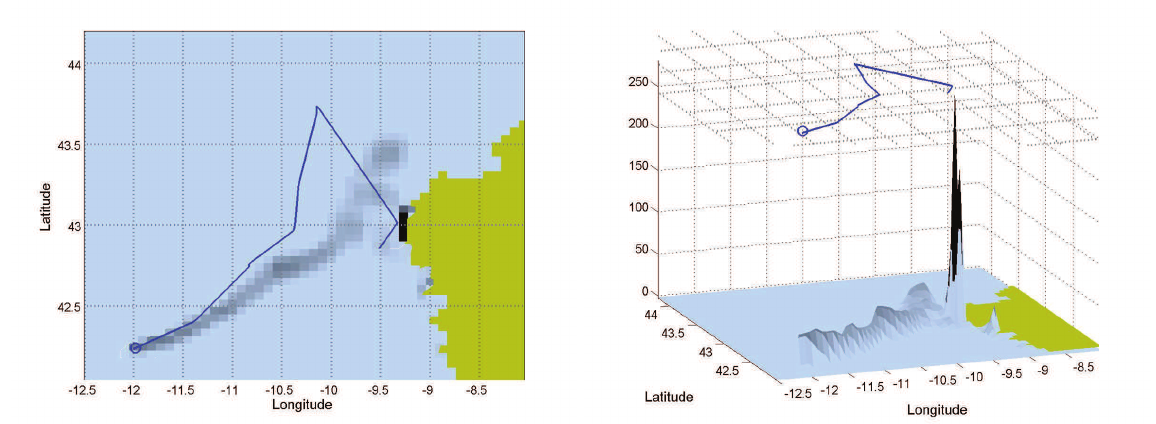
Fig. 4 (Left) Top view and (Right) 3D view of the final oil concentration distribution on 19 November 2002. Furthermore, the trajectory of the Prestige ship (continuous line) and the final position of the Prestige ship (o) are also